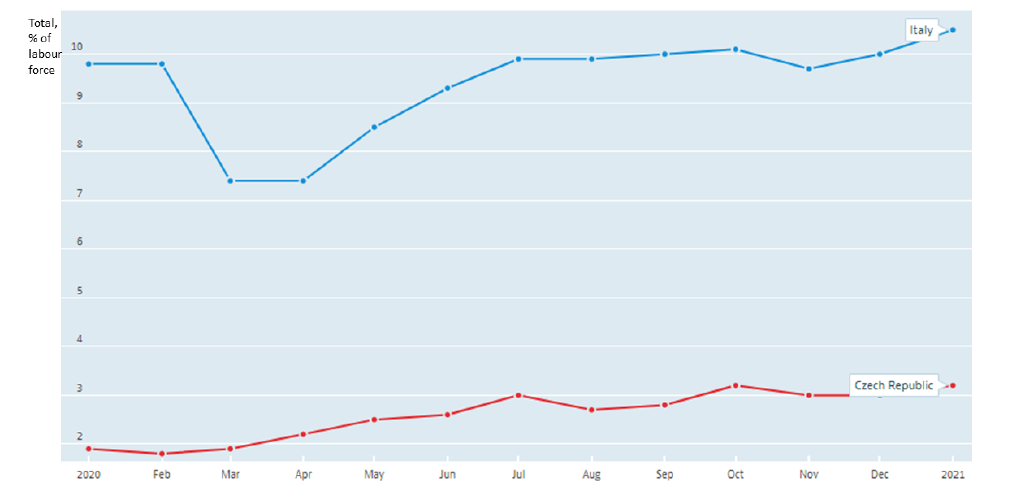
Figure 3. The negative impact of COVID-19 outbreaks on UR in Italy and the Czech Republic [20].